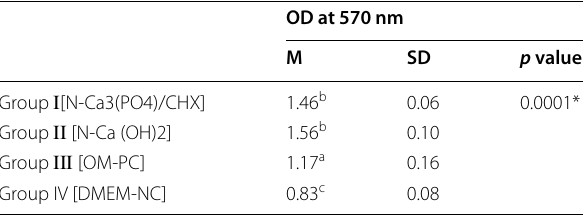
Incubation of HDPSCs treated with different medications for differentiation p : Probability level which is significant at p